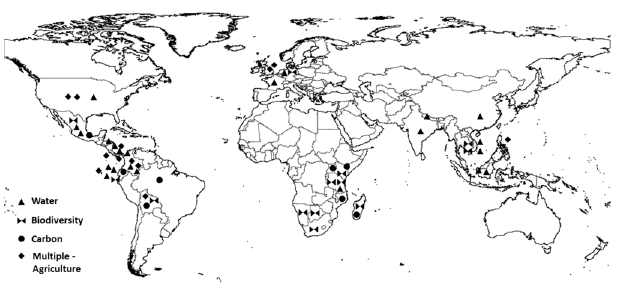
Fig 2. Location of PES schemes analysed.